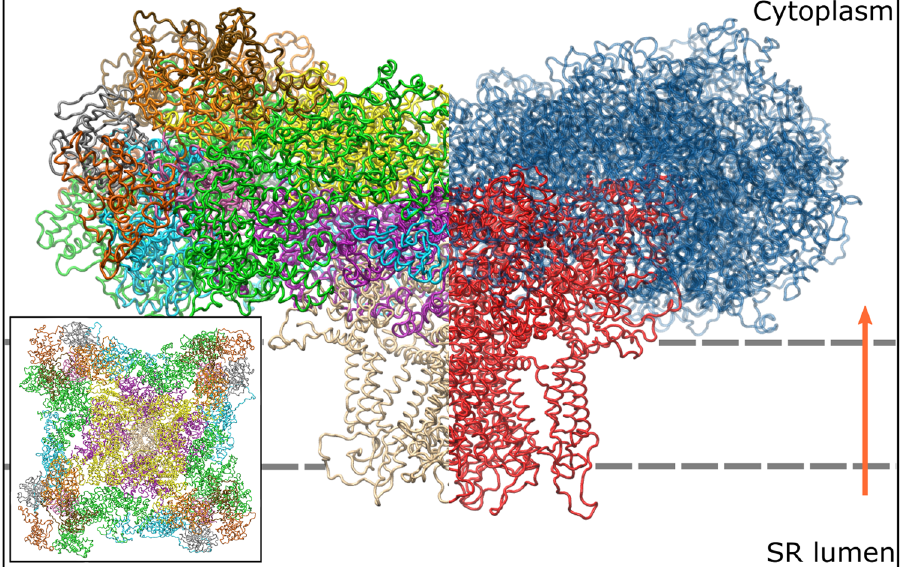
Figure 1. Side view of the RyR1-model. The left side is color-coded according to the domains of the receptor. Major domains are the N-terminal domain ( ), the handle domains ( ), the helical domains ( ), the central domain ( ) and the channel domain ( ). The right side highlights the reduced model, consisting of the central and channel domains, in red. The orange arrow indicates the direction of the calcium current from the SR into the cytoplasm. A top-view is shown in the